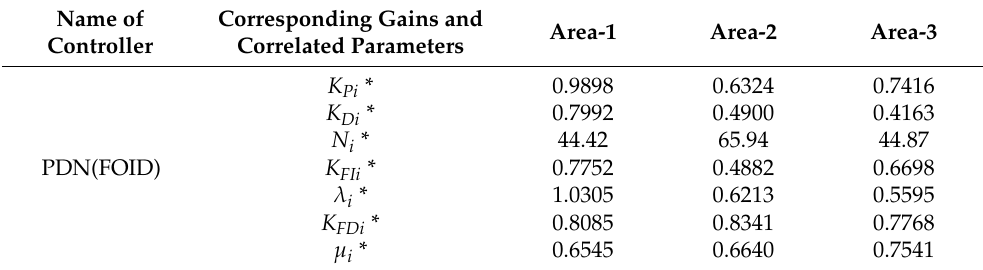
Table 6. Finest values of gains and related parameters of PDN(FOID) controllers for scheme-3.